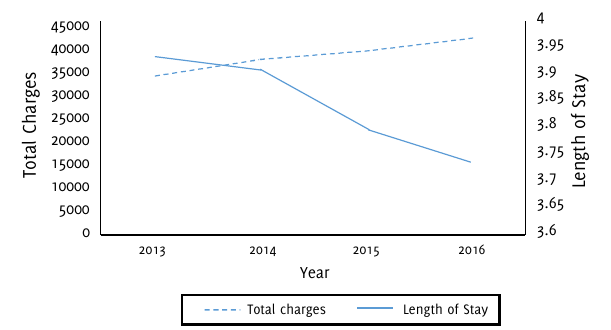
Figure 3 . Trends in Total Charges and Length of Stay in